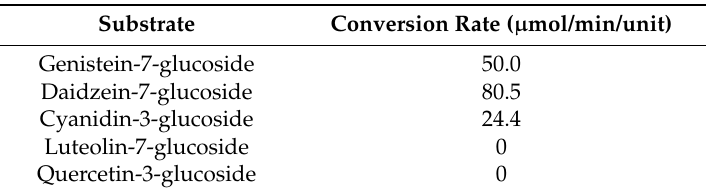
Figure 5. Chemical structures of the flavonoids. 1, Genistin; 2, Daidzin; 3, Cyanidin 3- O -glucoside chloride; 4, Luteolin 7-glucoside; 5, Quercetin 3- β -glucoside. Table 4. The conversion rates of flavonoids (as substrates).